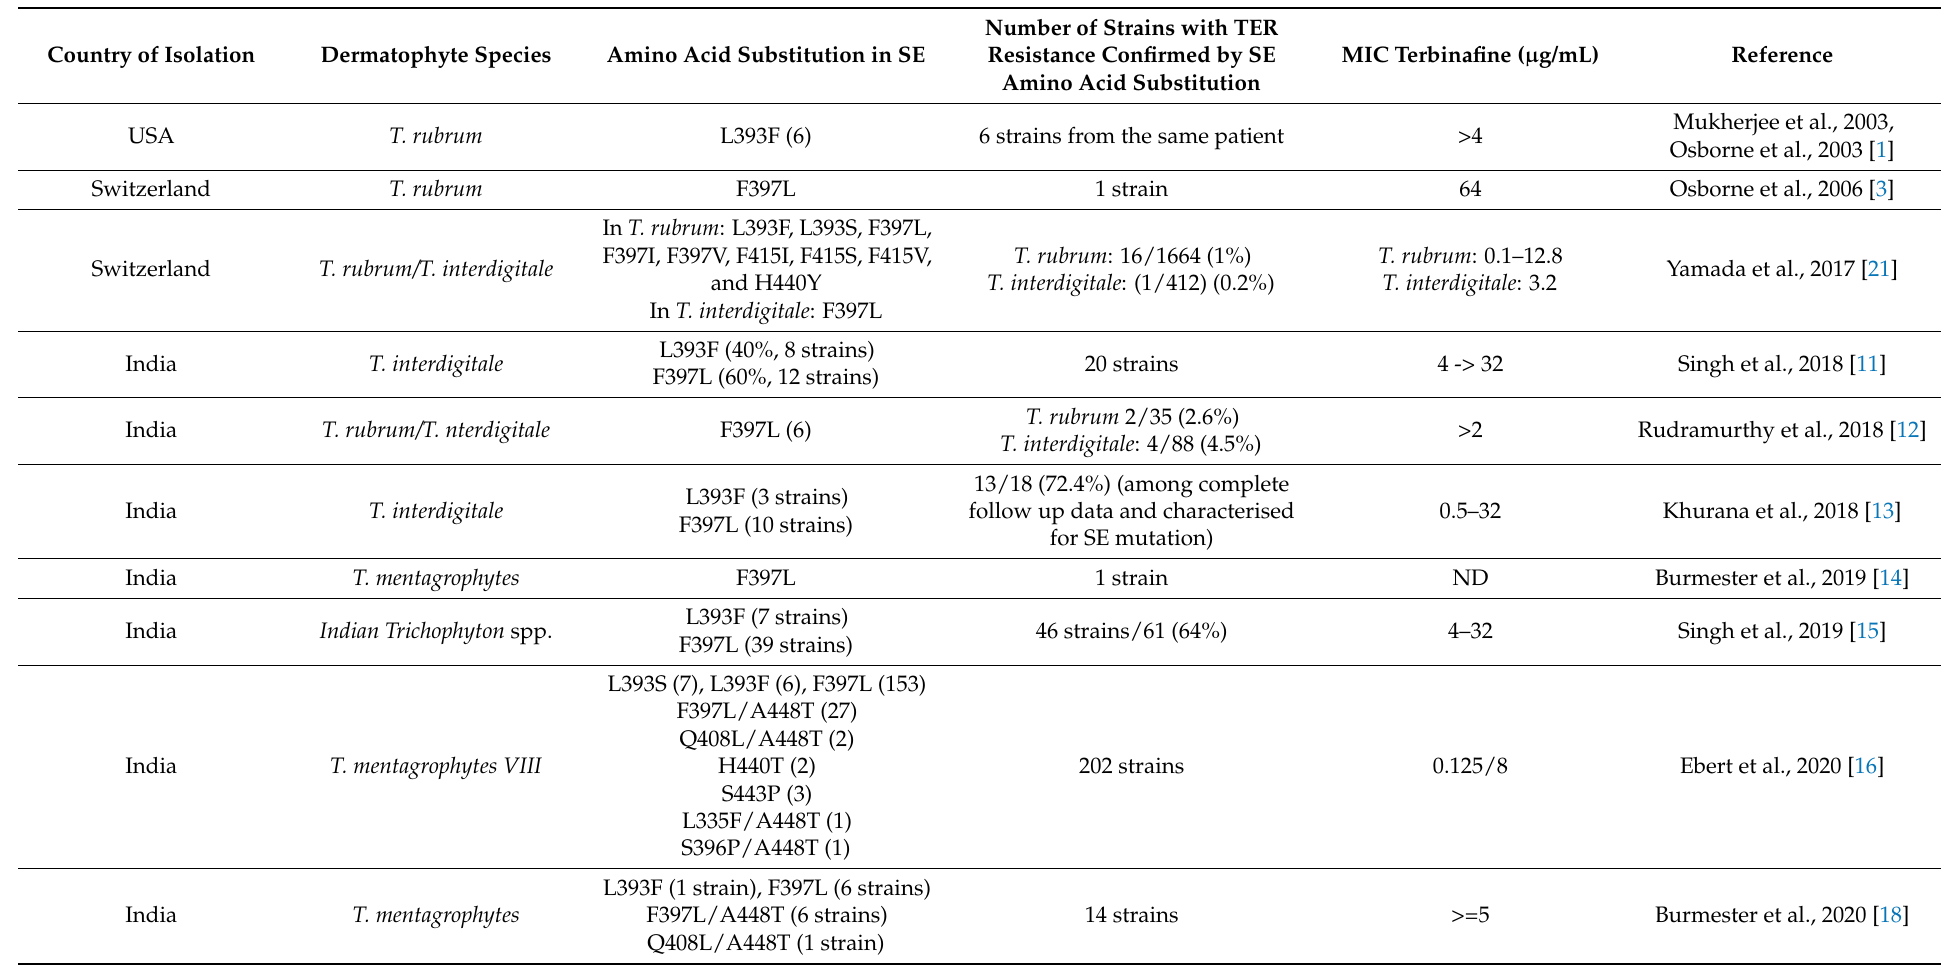
Table 1. Summary of amino acid substitutions and MICs values observed in terbinafine resistant strains isolated in previous studies. ND = not determined, MIC = minimum inhibitory concentration, SE = squalene